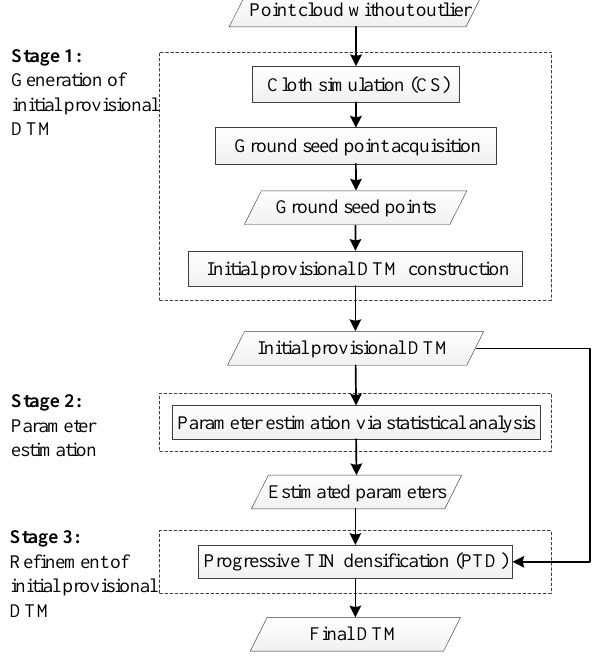
Figure 3. Flowchart of the proposed algorithm.